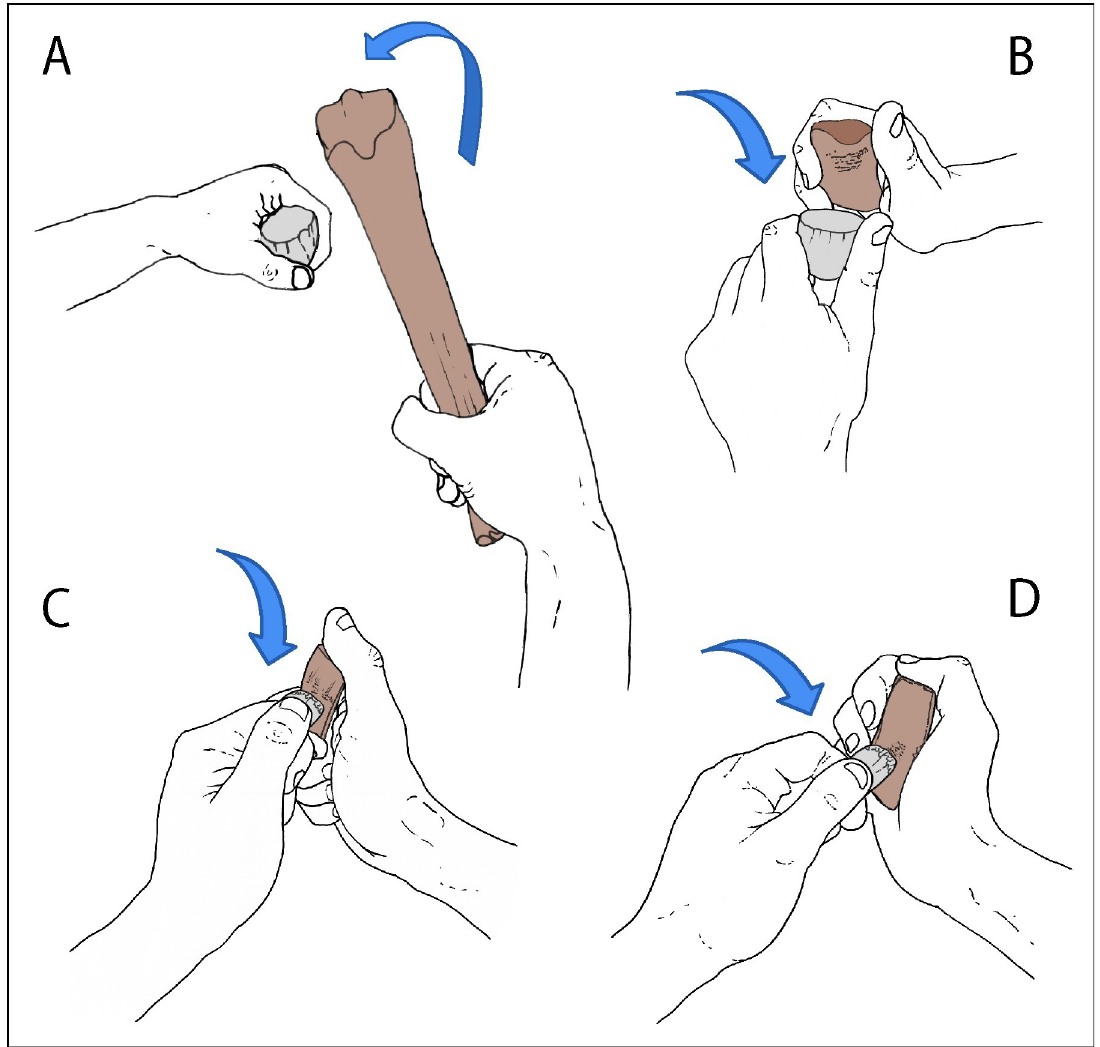
Fig 14. A-D. Magdalenian techniques of knapping flint tools at Gough’s Cave. A. Horse metapodial (e.g. M50025) used as a hammer to detach blades/bladelets from a core; B. horse phalanx (UNREG 3482) used as a hammer to remove small blades or flakes, or for retouching an edge; C. horse incisor (M49811) used as an active retoucher ( sensu [85]) in pressure-flaking; D. horse molar (M50064) used as a passive retoucher ( sensu [85]) in pressure-flaking.